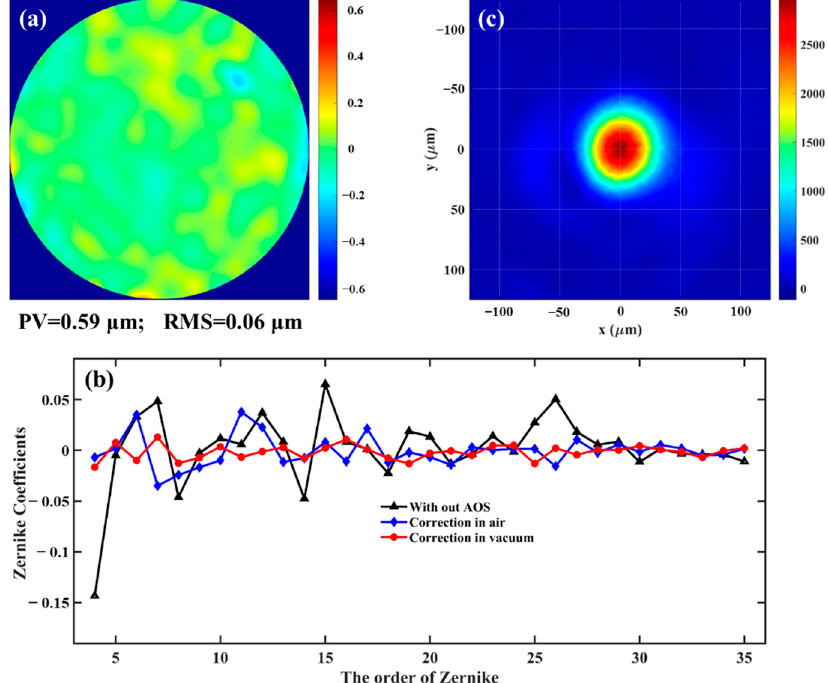
Figure 4. ( a ) The wavefront map measured at WFS after AOS closed-loop operation in vacuum; ( b ) the Zernike coefficients of the wavefront maps before and after correction; ( c ) the focal spot image measured by CCD after AOS closed-loop operation in